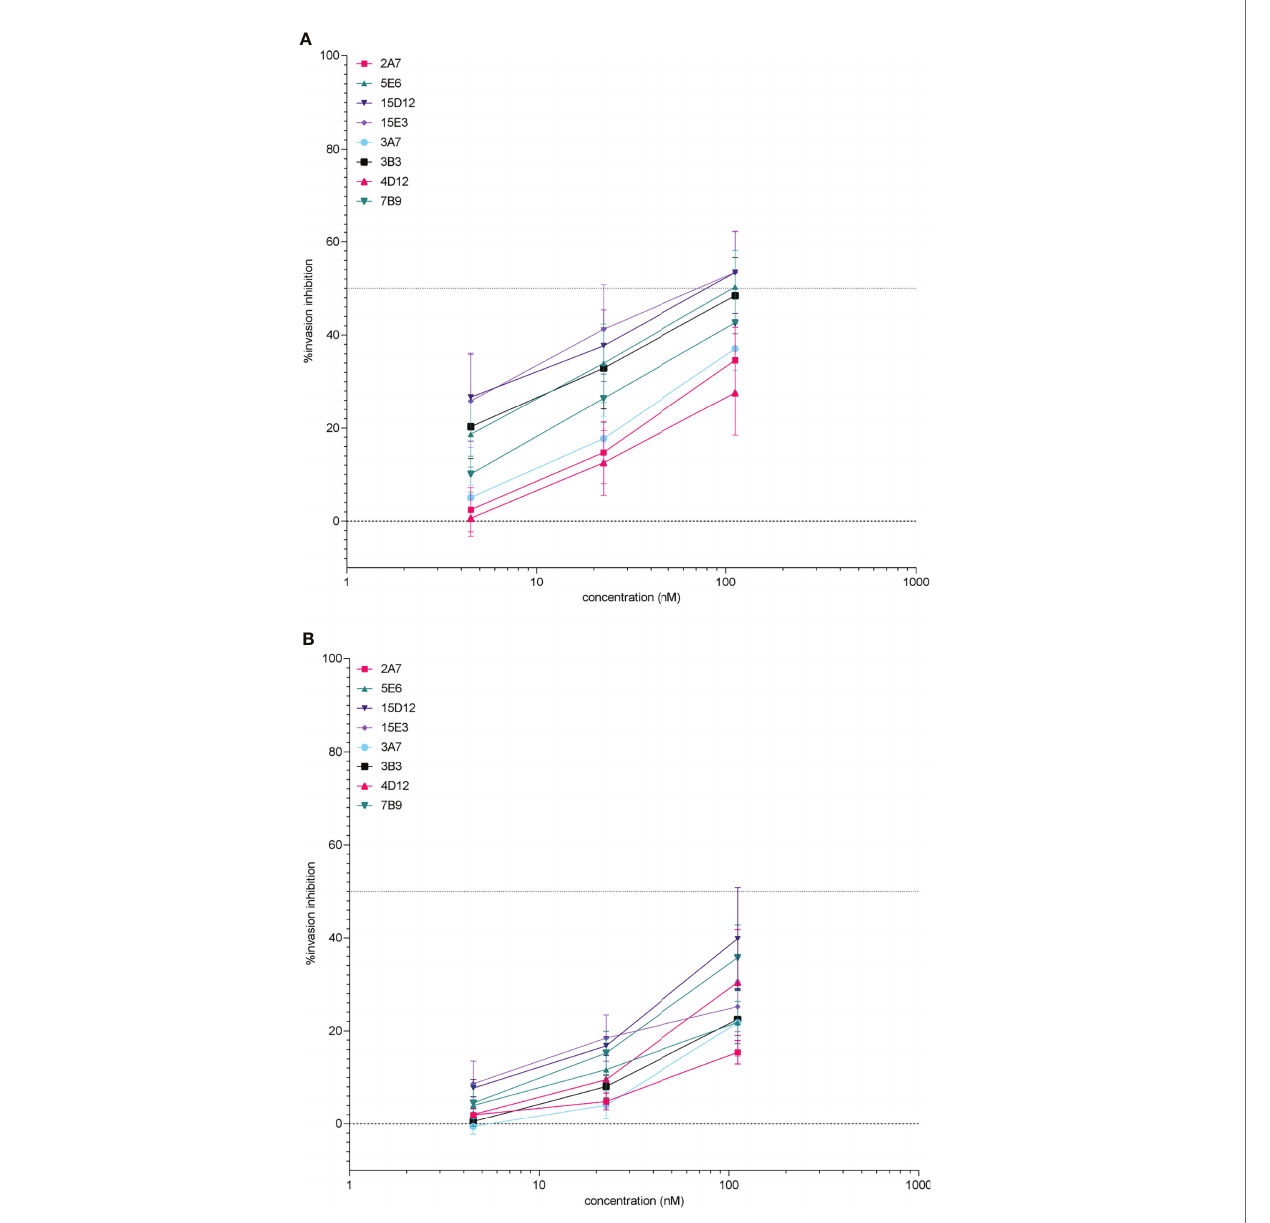
FIGURE 3 | Potency of puri fi ed anti- Pf RH5 and - Pf CyRPA monoclonal antibodies on P. falciparum FCR3 (A) and NF54 parasites (B) after incubation during one intra-erythrocytic cycle. Invasion inhibition was determined by measuring parasitaemia by fl ow cytometry, percentage inhibition was calculated relative to the no antibody control wells. The percentage inhibition and standard error of the mean (error bars) are shown for 3 replicate experiments. Assays were performed using antibodies diluted to 112.3, 22.5, and 4.5 nM (i.e. 16.4, 3.28, and 0.656 µg/ml respectively) to facilitate comparisons with data using cell culture supernatants. Recombinant hIgG1 clones 2A7#70, 5E6#36, 15D12#256, and 15E3#259 are all directed against Pf RH5. Antibodies to Pf CyRPA are 3A7# 22, 3B3#17, 4D12#30, and